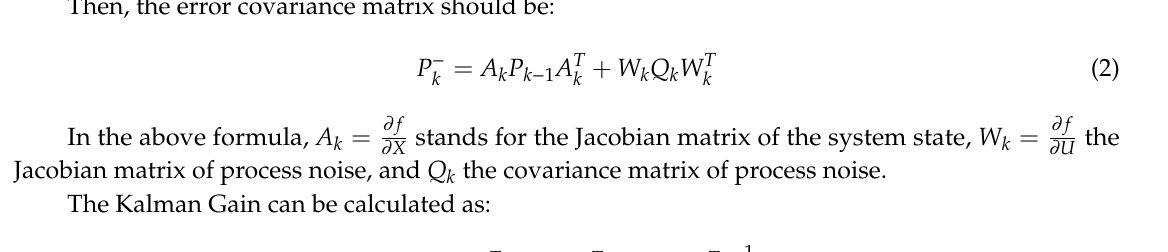
Figure 8. The surface schematic diagram of the fuzzy control